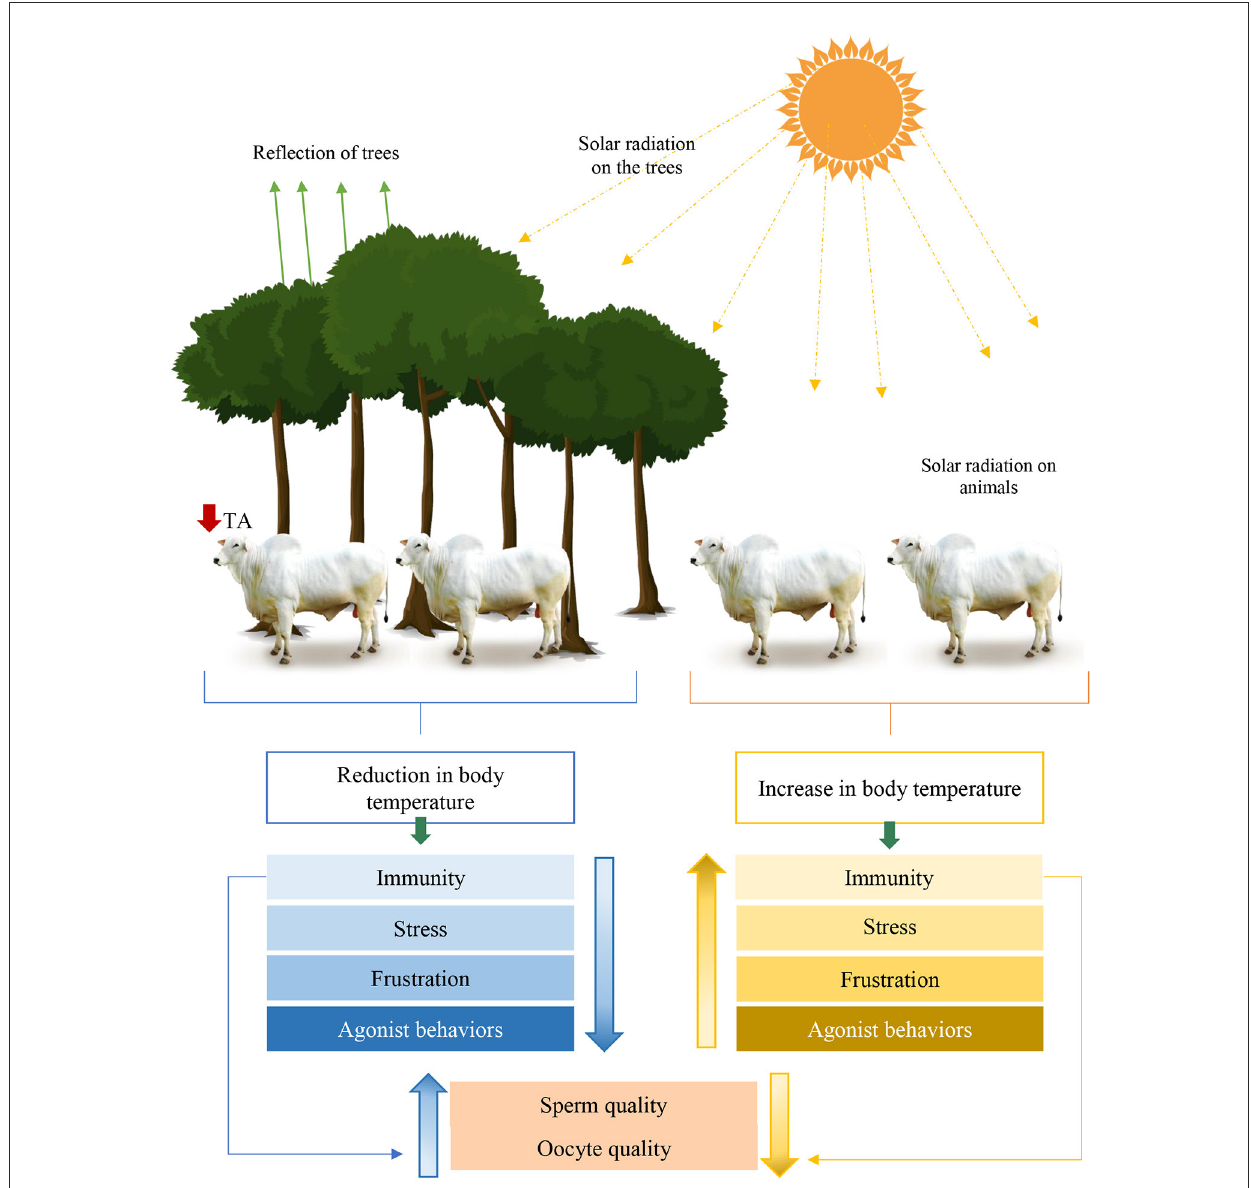
FIGURE9 Infographic of environmental effects on physiological, behavioral and stress parameters in male and female cattle conditioned in sun and shade systems. Adapted from Edwards-Callaway et al. ( 82). TA, Ambient